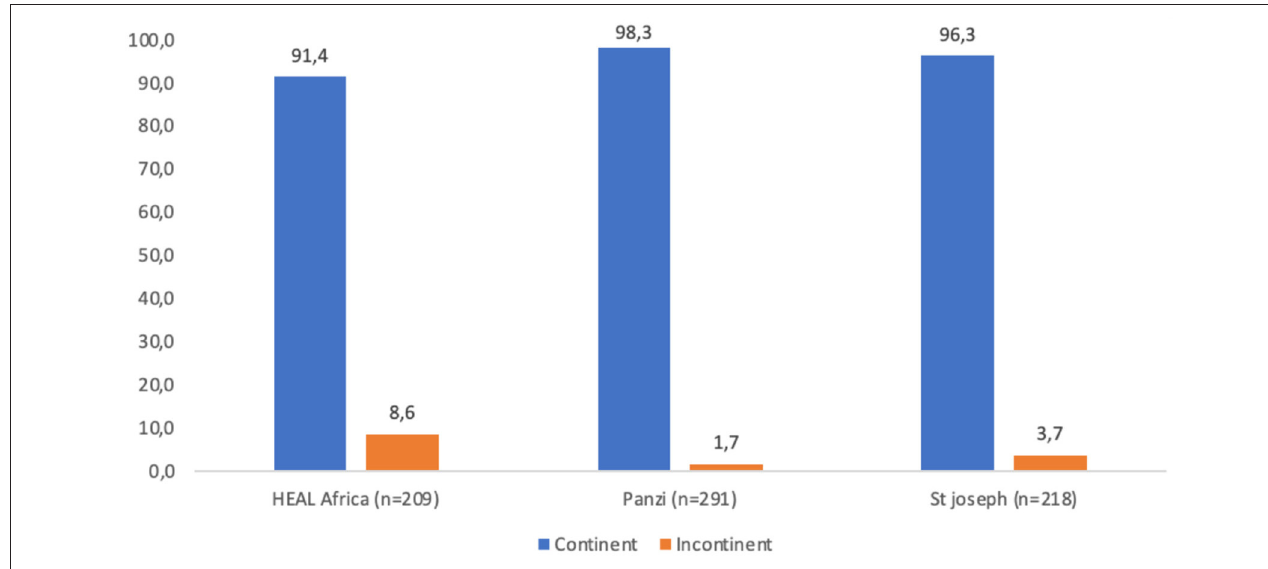
FIGURE 2 | Prevalence of residual urinary incontinence by fistula repair site among sites supported by the Fistula Care Plus project in the Democratic Republic of Congo, 2017–2019.